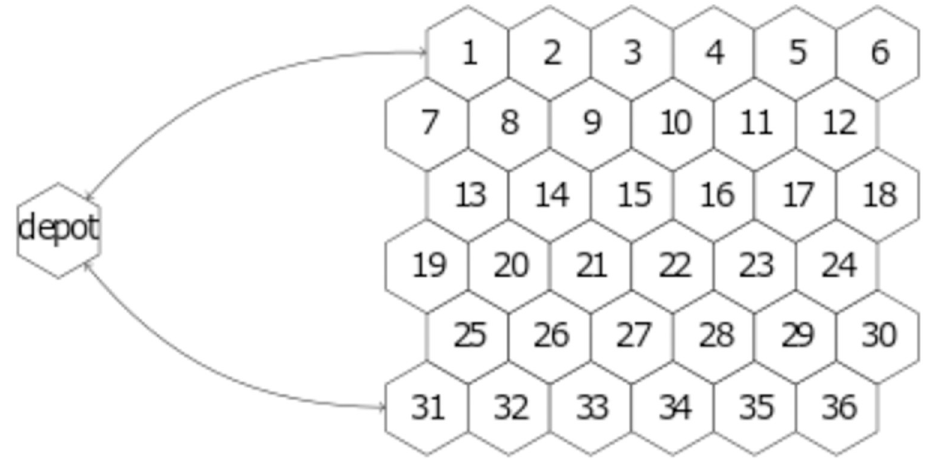
Fig 2. Diagram of mission site locations and depot connectivity. The sites are on a 6-by-6 hexagonal grid and sites that share an edge are connected. In addition, mission sites 1 and 31 are connected to the depot as indicated by the arrows.